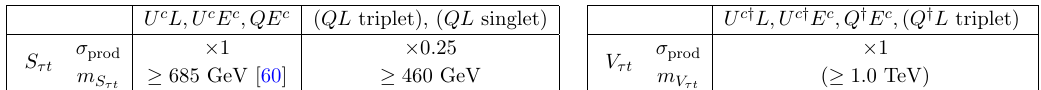
Figure 16 . Bounds on scalar and vector MLQs which decay into ( (cid:28)t )( (cid:28)t ) (cid:12)nal states. The observed 95% CL upper limit on the production cross section times branching fraction (black solid line) is taken from LQ searches in this (cid:12)nal state at CMS [60] which stopped at 800 GeV. The remainder of the analysis is analogous to (cid:12)gure 8.